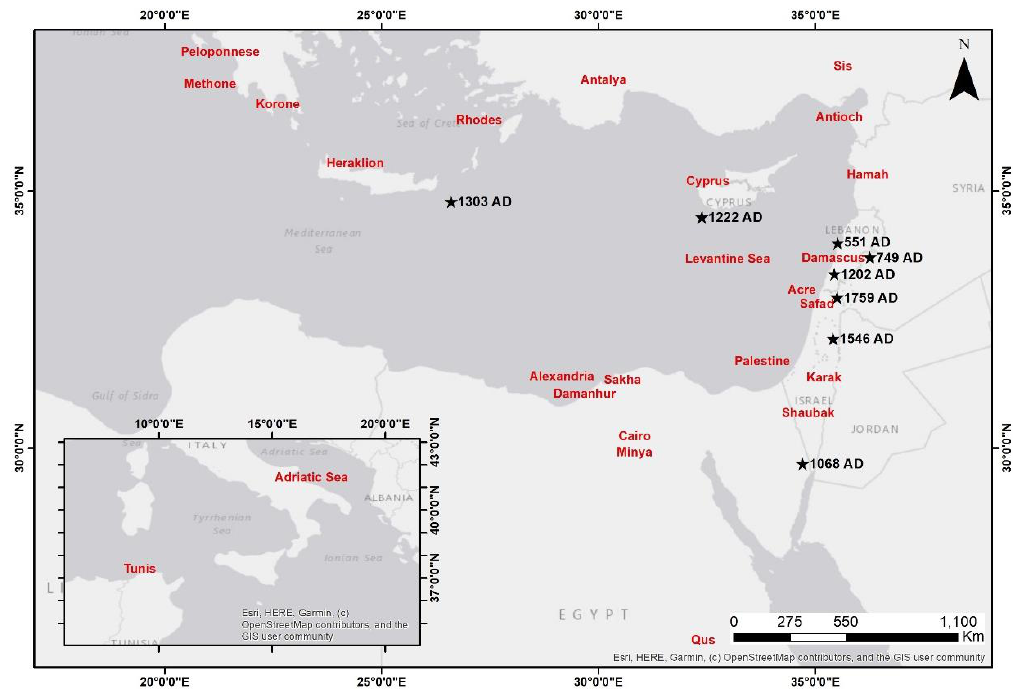
Figure 13. Location of the earthquakes cited in the text (black stars) and sites affected by the 1303 earthquake and tsunami (in red) (from [36,43,58]).